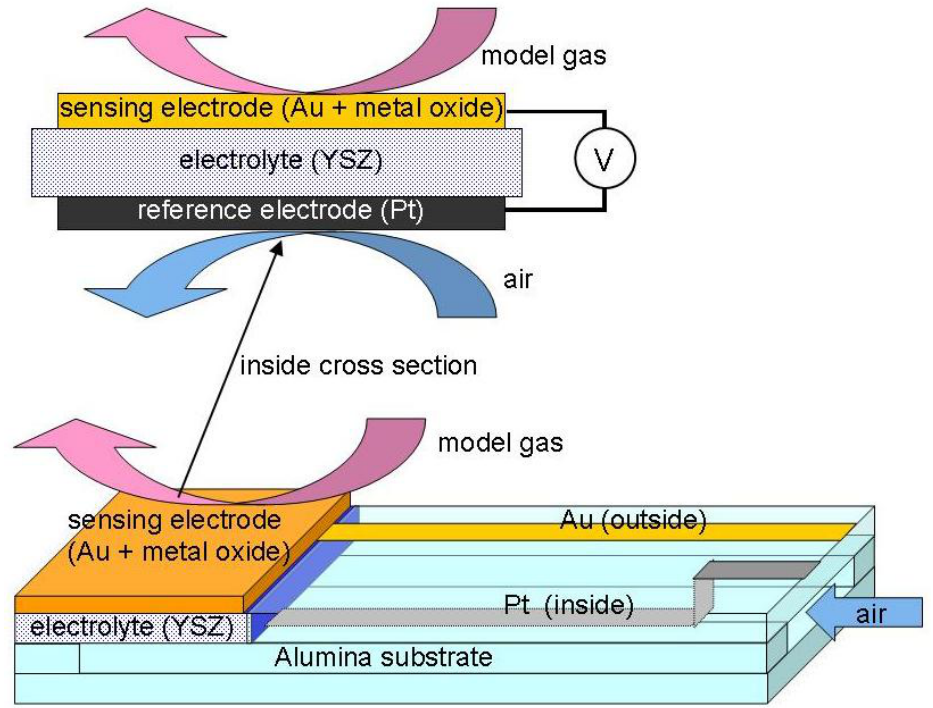
Figure 1. Schematic representation of the sensor examined in the present